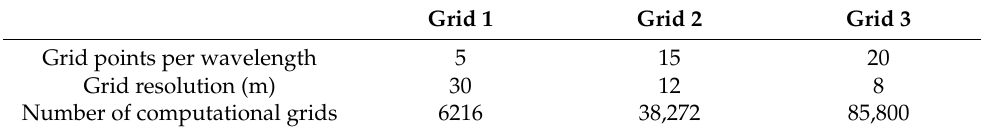
Table A2. Grid parameters for model D2.